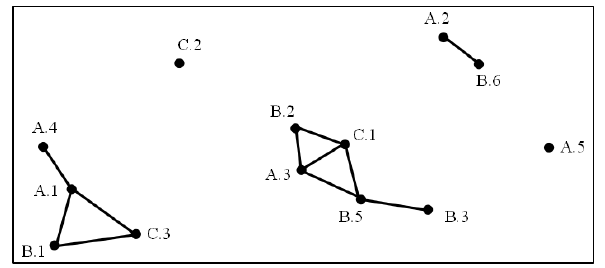
Figure 1. An example data set